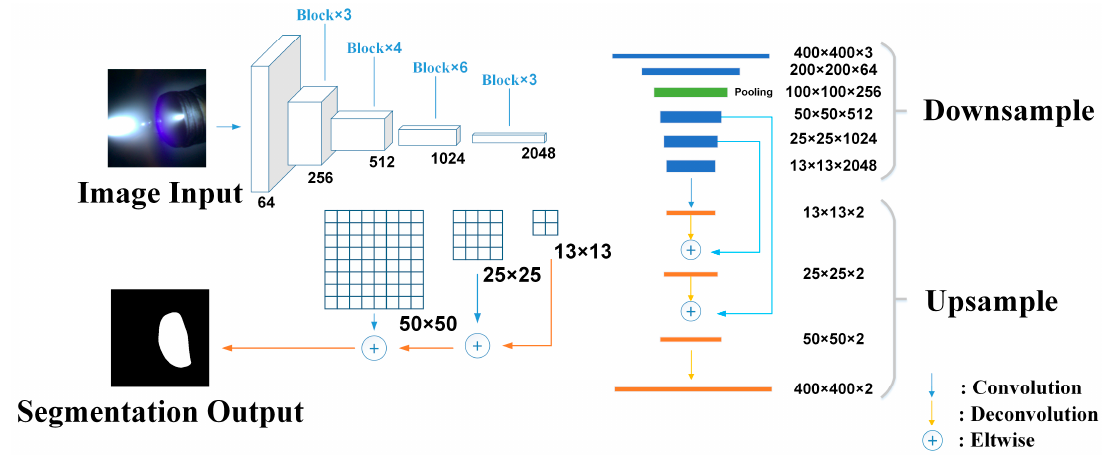
Figure 8. Res-Seg network structure.